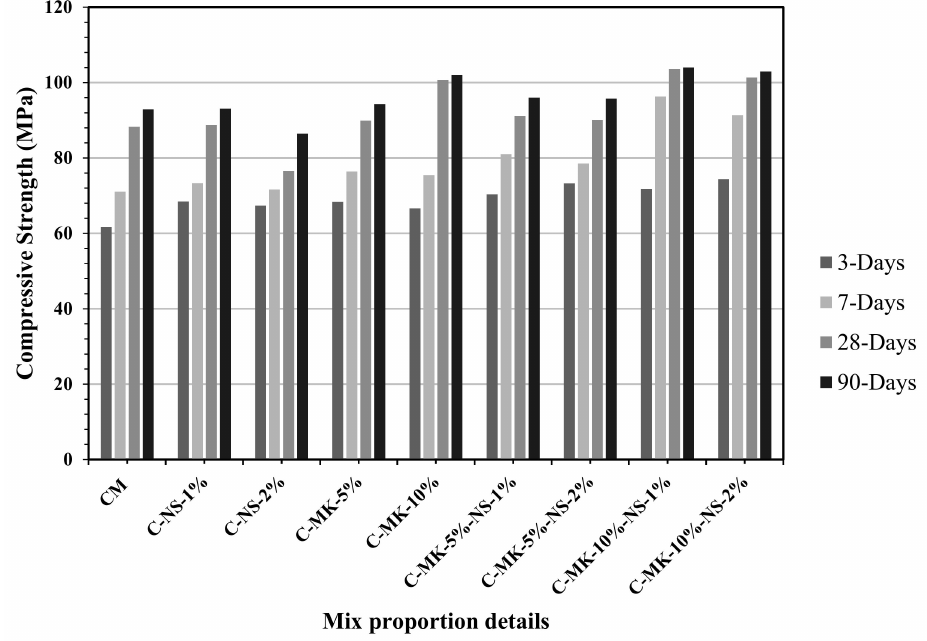
Figure 1. The e ff ects various combinations of MK and NS on the compressive strength of concrete determined at a di ff erent